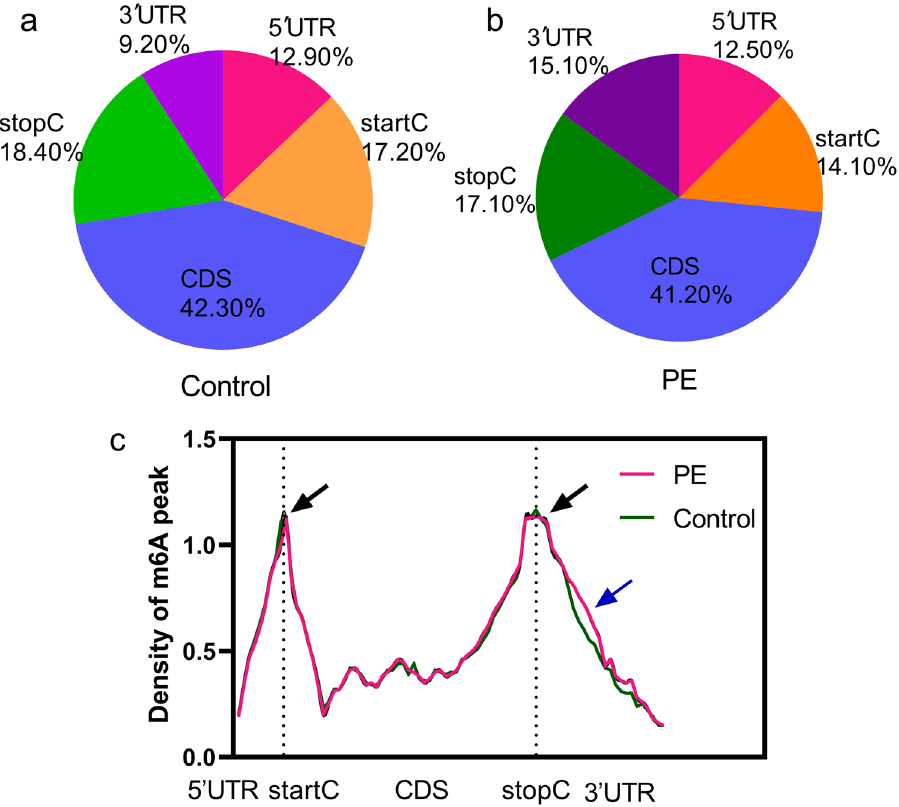
Figure 2. Results of m6A RNA sequencing data analysis with the HOMER or Python annotation tool. Proportions of m6A peaks distributed in the 5 ′ -untranslated region (5 ′ UTR), start codon (startC), coding DNA sequence (CDS), stop codon (stopC) and 3 ′ -untranslated region (3 ′ UTR) across the entire set of circRNA- corresponding transcripts in PE and control samples ( a , b ). Density distribution of m6A peaks across mRNA transcripts ( c ). m6A peaks were abundant near the startC or stop codon (stopC) (black arrow). We found that the density of m6A at the 3 ′ UTR in PE placentas was higher than that in control placentas (blue